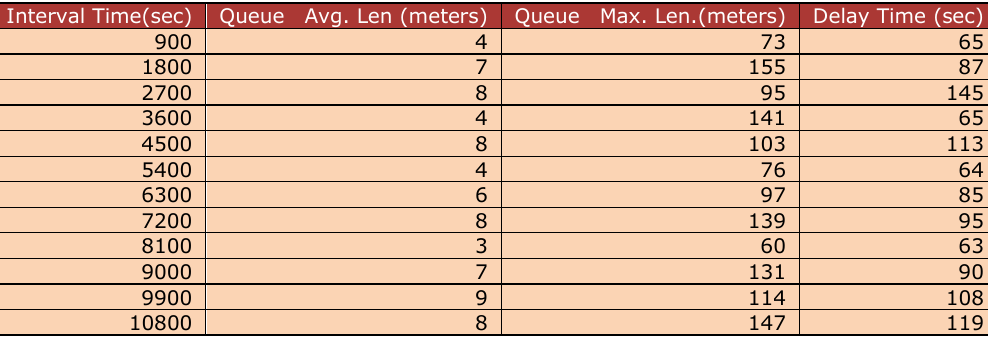
Table 7. Vehicles Queue Statistics at the 2 nd Congestion Position